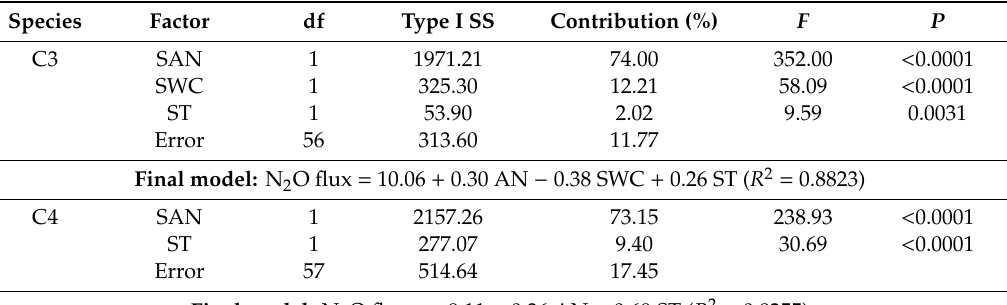
Table 4. The most parsimonious multiple linear regression model including soil available nitrogen (SAN, mg / kg), soil temperature (ST, ◦ C) or soil water content (SWC, g / cm 3 ), and their contributions to N 2 O flux ( µ g / m 2 / h) during growing seasons in C3 and C4 fields.